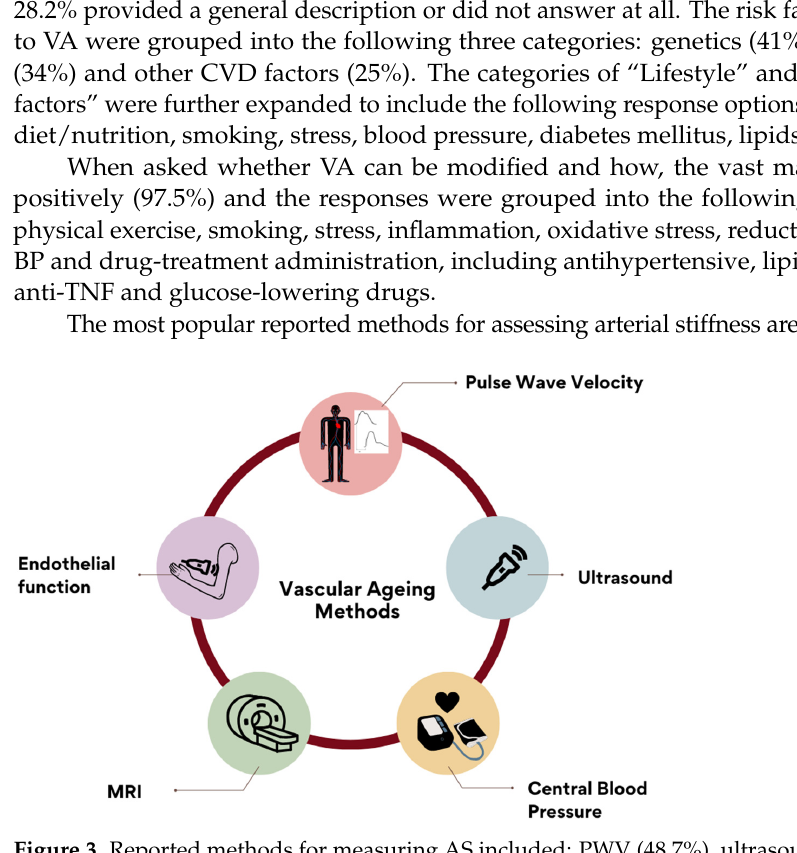
Figure 3. Reported methods for measuring AS included: PWV (48.7%), ultrasound imaging, central blood pressure, endothelial-function markers and magnetic-resonance imaging. Other answers in- cluded: coronary-calcium score, blood-pressure measurement, catheterization methods, oscillome- try, photoplethysmography, augmentation index and biochemical markers. These were recorded and included in the ‘Others’ open